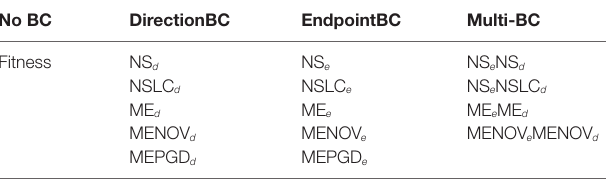
TaBle 2 | Fifteen treatments compared with three